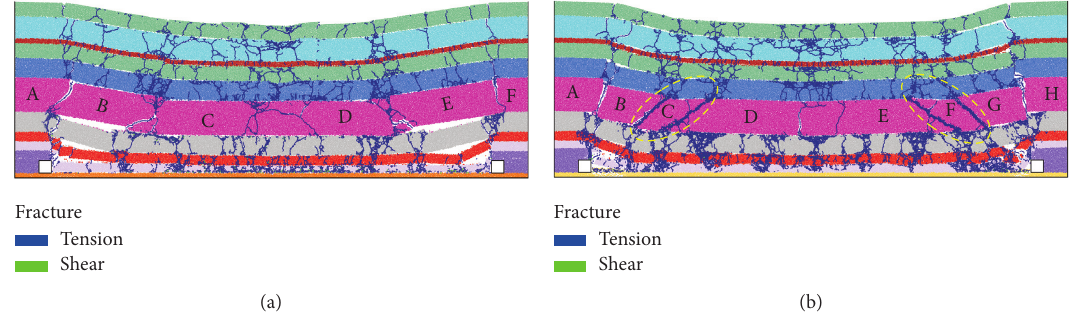
Figure 9: Overburden collapse and fracture development along the inclination of working face. (a) Nonblasting. (b)